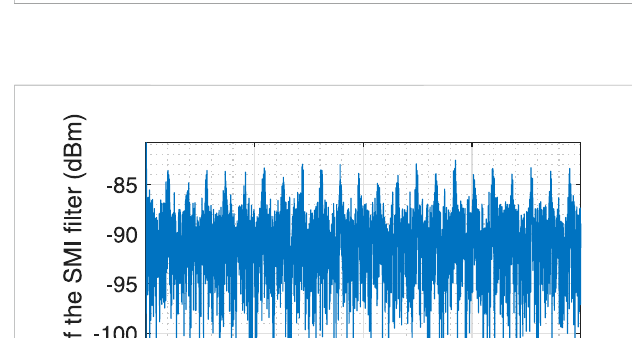
FIGURE 6 SINR loss of one-time simulation ( K = 720).